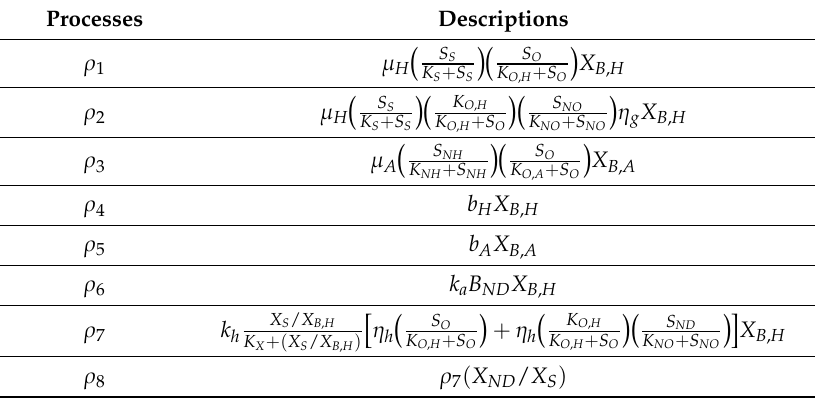
Table A7. Reaction rate of eight sub-reaction